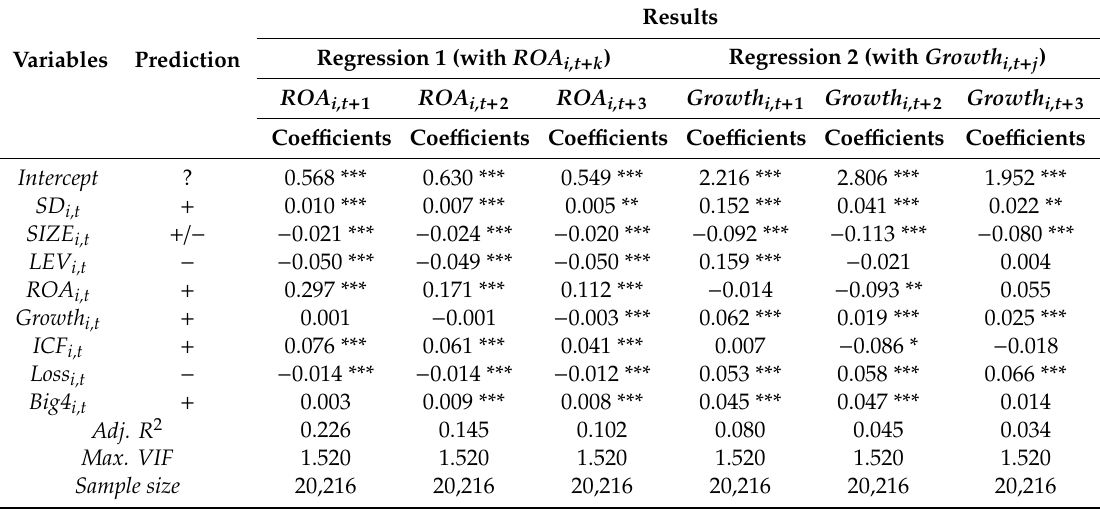
Table 5. Regression of future performance ( ROA i,t + k ) or growth sustainability ( Growth i,t + j ) on business strategy ( SD i,t ) a